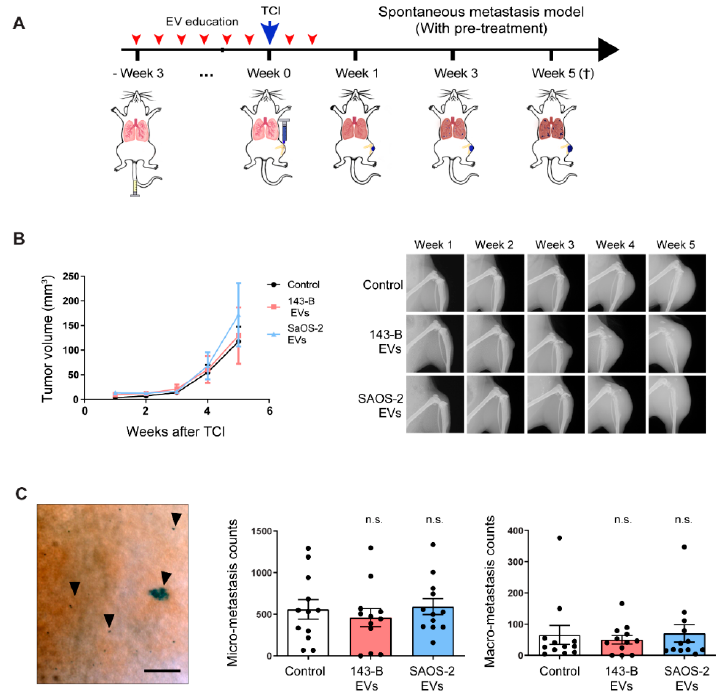
Figure 4. Pre-treatment with osteosarcoma cell-derived EVs does not affect primary tumor growth and spontaneous metastasis in an orthotopic 143-B model. ( A ) Scheme of the experimental setup. ( B ) Primary tumor growth monitored by caliper measurements of the tumor volume at indicated time points (left panel) and representative X-ray images of tumor bearing legs (right panel). ( C ) Representative image of pulmonary metastasis (left panel). Scale bar, 500 µm. Quantification of X-gal stained micro-metastases and macro-metastasis (middle and right panels) on lung mounts of treated mice sacrificed 5 weeks after tumor cell injection; n = 12 mice per group. (n.s., non-significant; Bonferroni’s one-way ANOVA test).